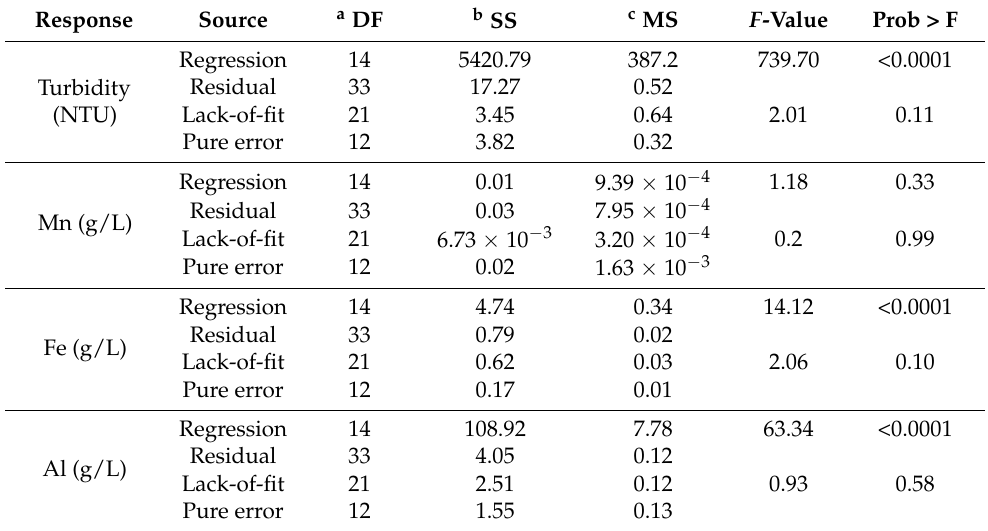
Table 4. ANOVA results for the four responses including turbidity and residual concentration of Mn, Fe, and Al.